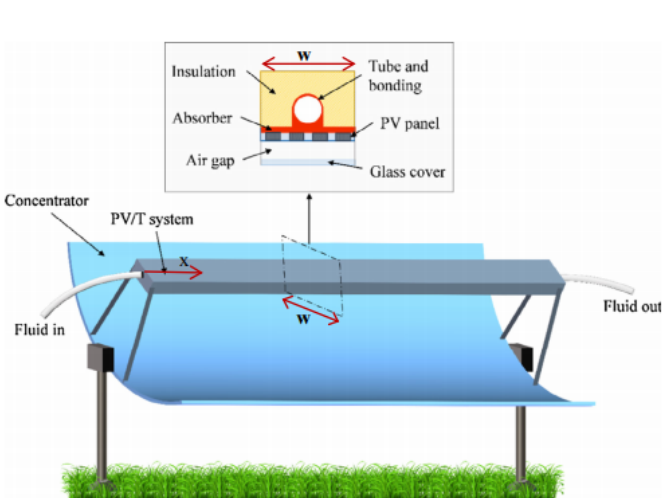
Figure 18. Cylindro-parabolic solar concentrator proposed by Yazdanifard et al. [25]. Reprinted from F. Yazdanifard et al., Performance of a parabolic trough concentrating photovoltaic/thermal system: effects of flow regime, design parameters, and using nanofluids. Energy Conversion and Management 2017 1265–1277, with permission from Elsevier. T,